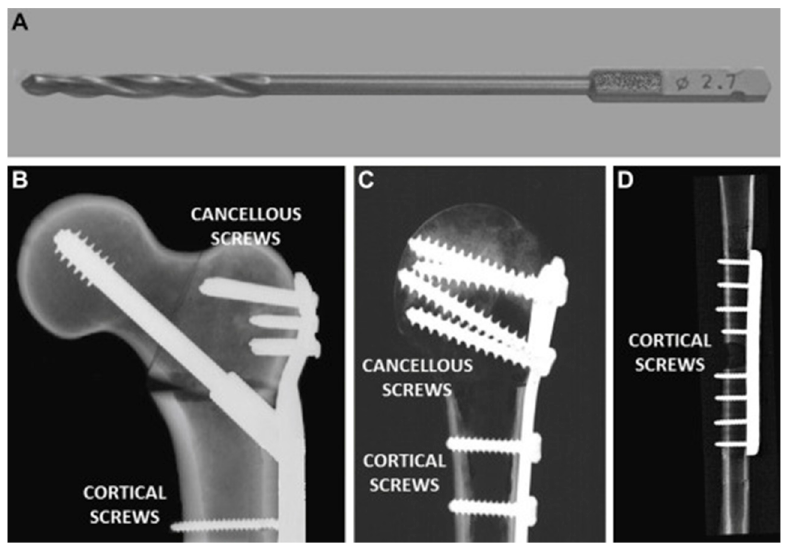
Figure 16. Surgical drilling for fracture repair. ( A ) Surgical drill bit, ( B ) proximal femur, ( C ) proximal humerus, ( D ) humeral diaphysis [121].